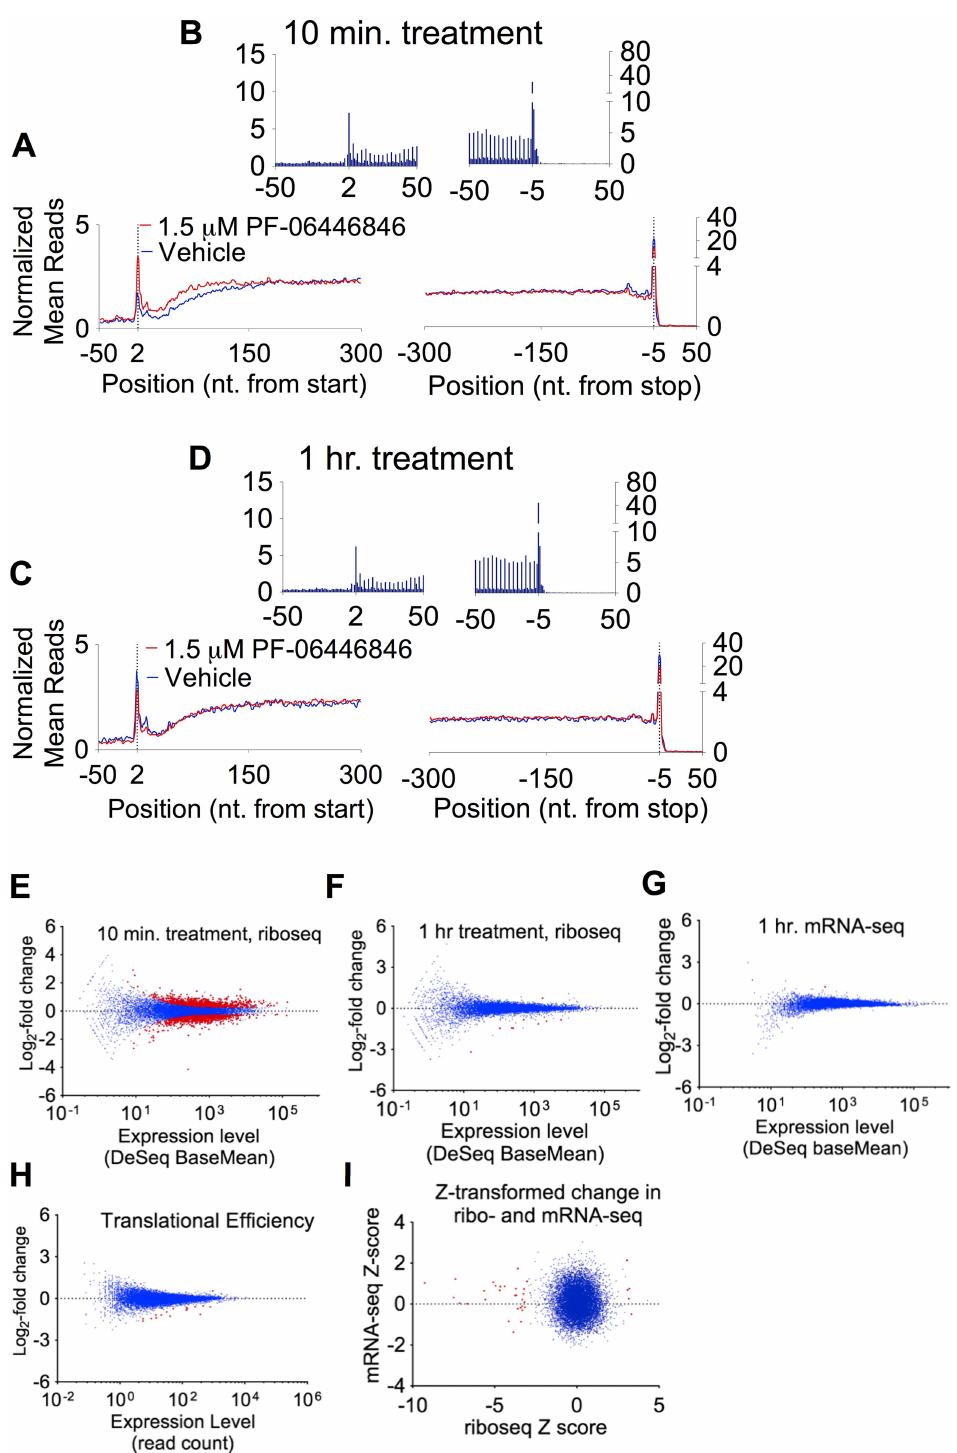
Fig 3. PF-06446846 does not cause widespread ribosomal stalling. (A–D) Metageneplots showingthe normalized mean read counts at the nucleotide(nt) positionsrelative to the start and stop sites for cells treated with 1.5 μ M PF-06446846 (red trace) and vehicle(blue trace) for (A–B) 10-min treatment and (C–D) 1-h treatment. In panelsA–D, reads positionsare displayedaccordingto the inferred ribosomal P-site [19]. In panelsA and C, the values are averagedover three nucleotidesfor clarity. PanelsB and D represent